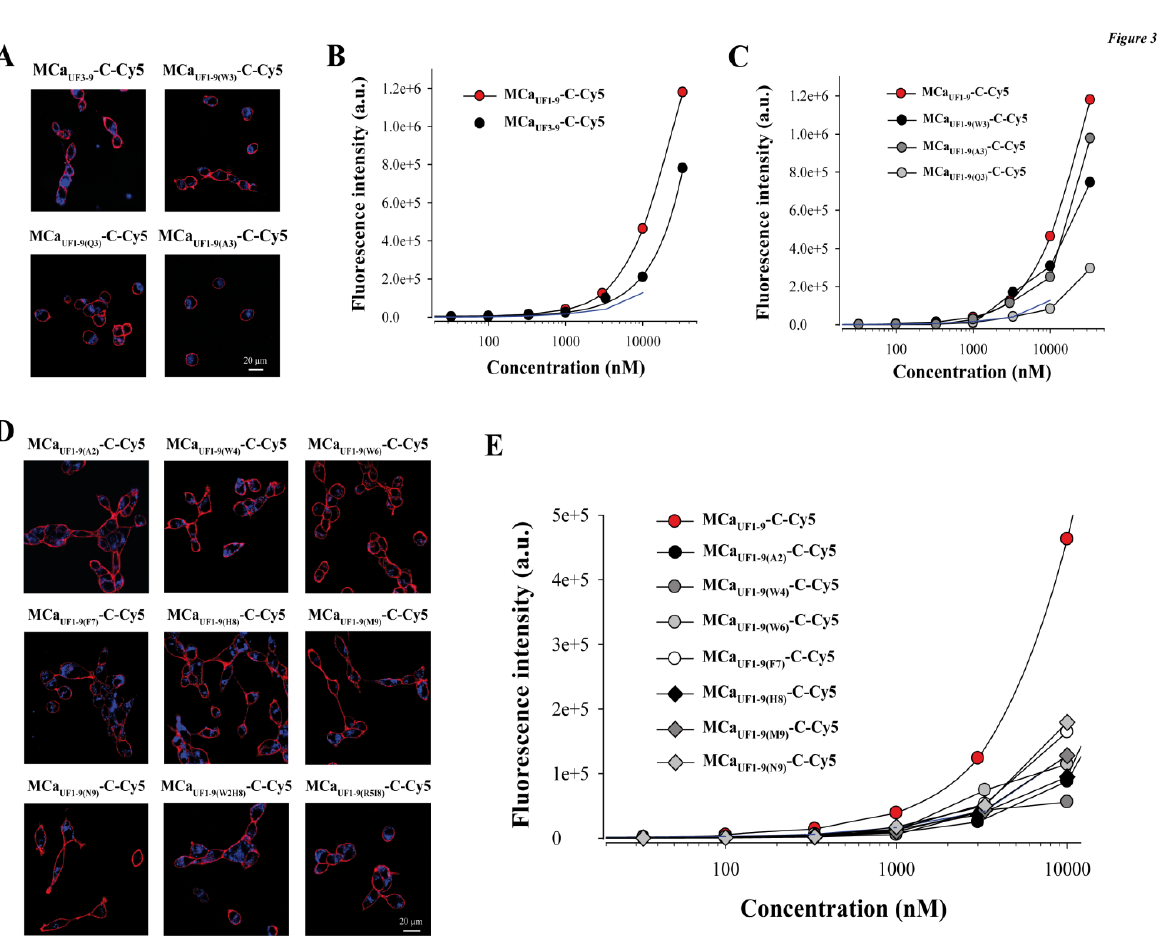
Figure 3. Structural determinants of MCa peptide penetration. ( A ) Confocal images UF1-9 illustrating the penetration of 3 µM MCa -C-Cy5, MCa -C-Cy5, MCa -C- UF3-9 UF1-9(W3) UF1-9(Q3) Cy5 or MCa -C-Cy5 into F98 cells. 2 h incubation time before washout and UF1-9(A3) imaging. ( B ) Effect of N-terminal peptide truncation on cell penetration efficacy of MCa -C-Cy5 as assessed by flow cytometry. ( C ) Effect of point mutation at position 3 UF1-9 on the cell penetration efficacy of MCa -C-Cy5. ( D ) Confocal images illustrating the UF1-9 penetration of 3 µM single or double point mutated MCa -C-Cy5 peptide into F98 UF1-9 cells. (E) Effect of single point mutations on the cell penetration efficacy of MCa -C- UF1-9 Cy5 as assessed by flow